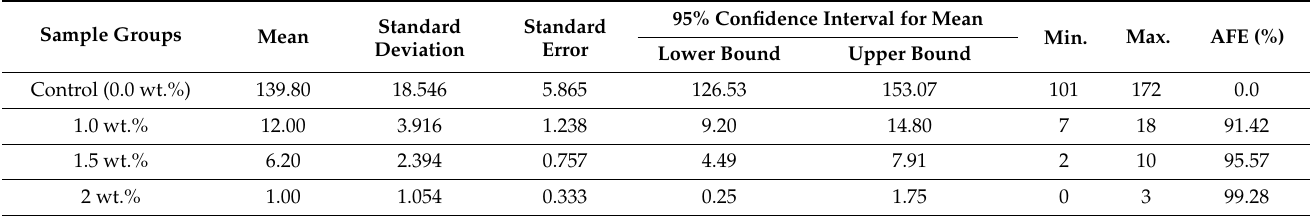
Table 2. Descriptive statistics and AFE of the C. albicans viable count results for the experimental and control groups.